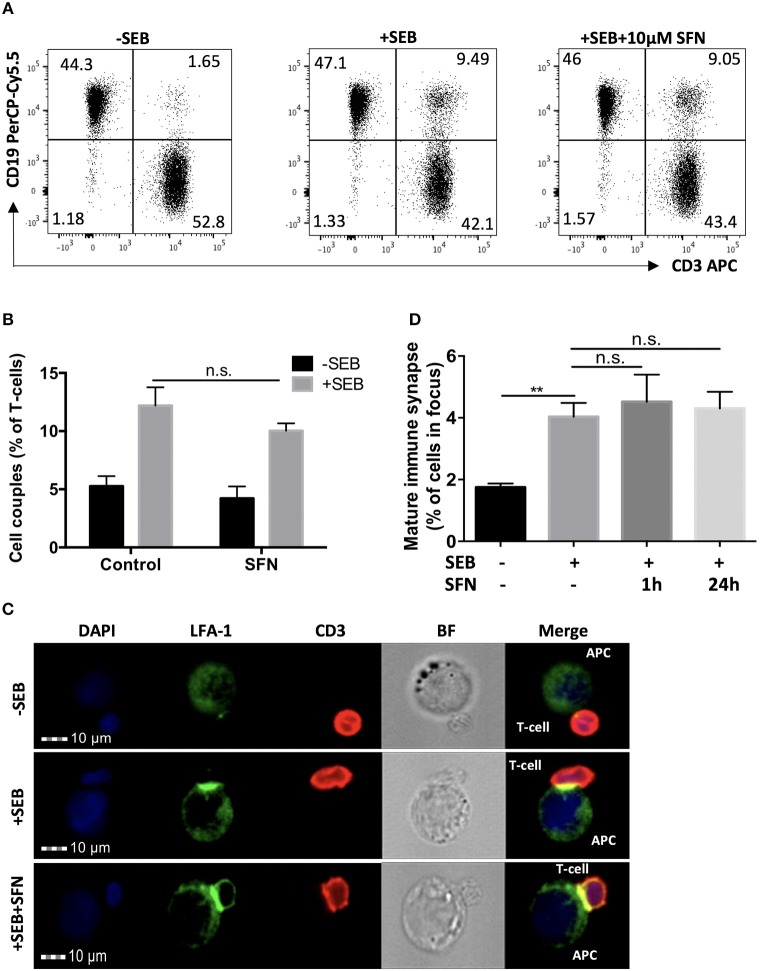
Intact immune synapse formation of SFN treated T-cells. (A) Dot plots of T-cell/APC couple formation were identified by flow cytometry-based conjugate assay via CD3 and CD19 expression. T-cells were treated without (left and middle panel) or with (right panel) 10 μM SFN prior to incubation with APCs in the absence (left panel) or presence (middle and right panel) of SEB. Dot plots are representative for three experiments. (B) Quantification of the couple formation between T-cells and APCs (n = 3; mean; SE). (C) Multispectral imaging flow cytometry analysis of mature synapse formation. T-cells were treated without (upper and middle panels) or with (lower panel) 10 μM SFN prior to incubation with APCs in absence (upper panel) or presence (middle and lower panels) of SEB. Cells were stained for nuclei (DAPI, blue), LFA-1 (green) and CD3 (red). The merged image represents the digital overlay of all three colors. Bright field (BF) and fluorescence images are representative for three experiments. (D) Quantification of the mature immune synapse between T-cells and APCs. At least 15,000 cells were acquired by imaging flow cytometry for each condition (n = 3; mean; SE; **p < 0.01).